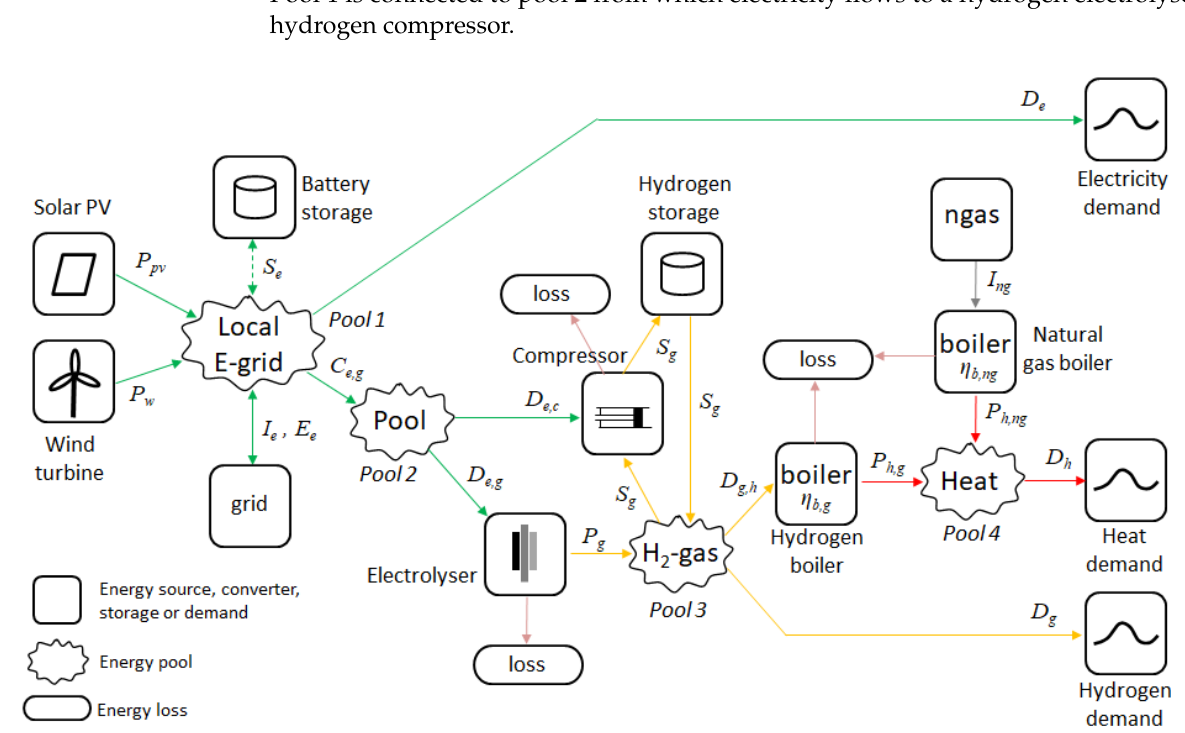
Figure 1. System asset and energy flow schedule.